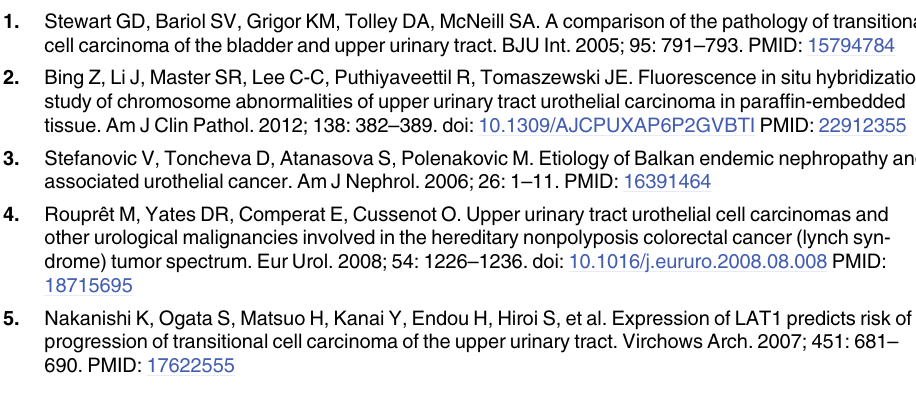
S1 Fig. Hierarchical clustering of tumors of all stages shows no differential clustering between UTUC and UCB. S2 Fig. Differential clustering between UTUC (right side) and UCB (left side) in pT3